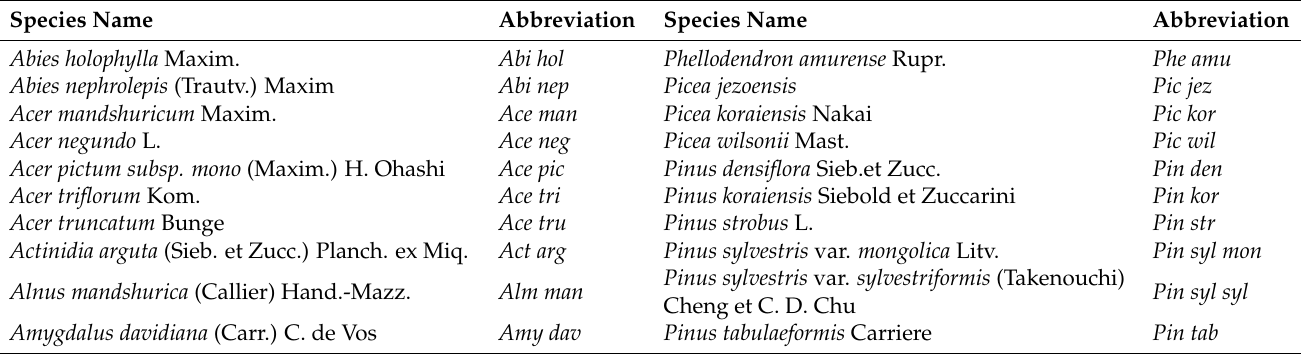
Table A1. Species botanical names and abbreviations of middle-aged trees in Changchun